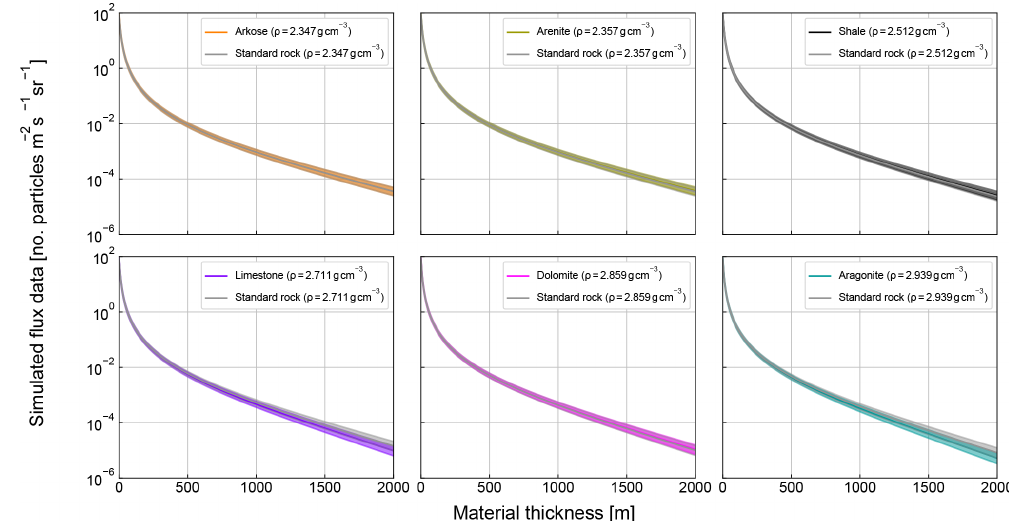
Figure 6. Simulated muon intensity vs. thickness of the six sedimentary rocks from Table 1 and a density-modified standard rock. The mean flux is indicated by a bold line and 1 σ bounds are indicated by the shaded area.